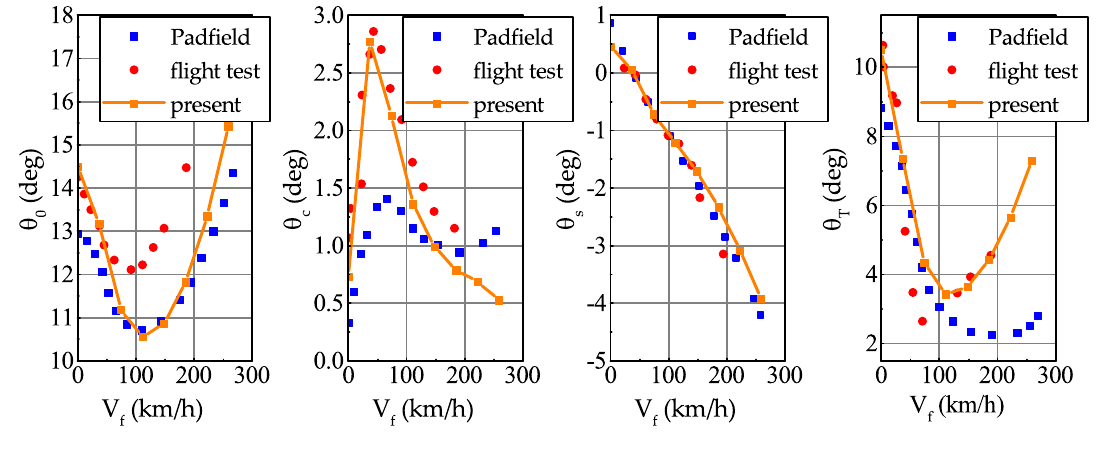
Figure 4. Bo 105 trim